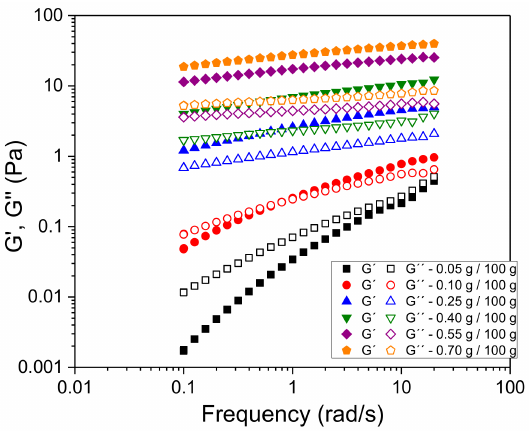
Figure 5. Mechanical spectra for fennel oil nanoemulsions with different xanthan gum concentration at 20 ◦ C. Data shown are the average values of three replicates. The standard deviation for all the experiments was lower than 5%.